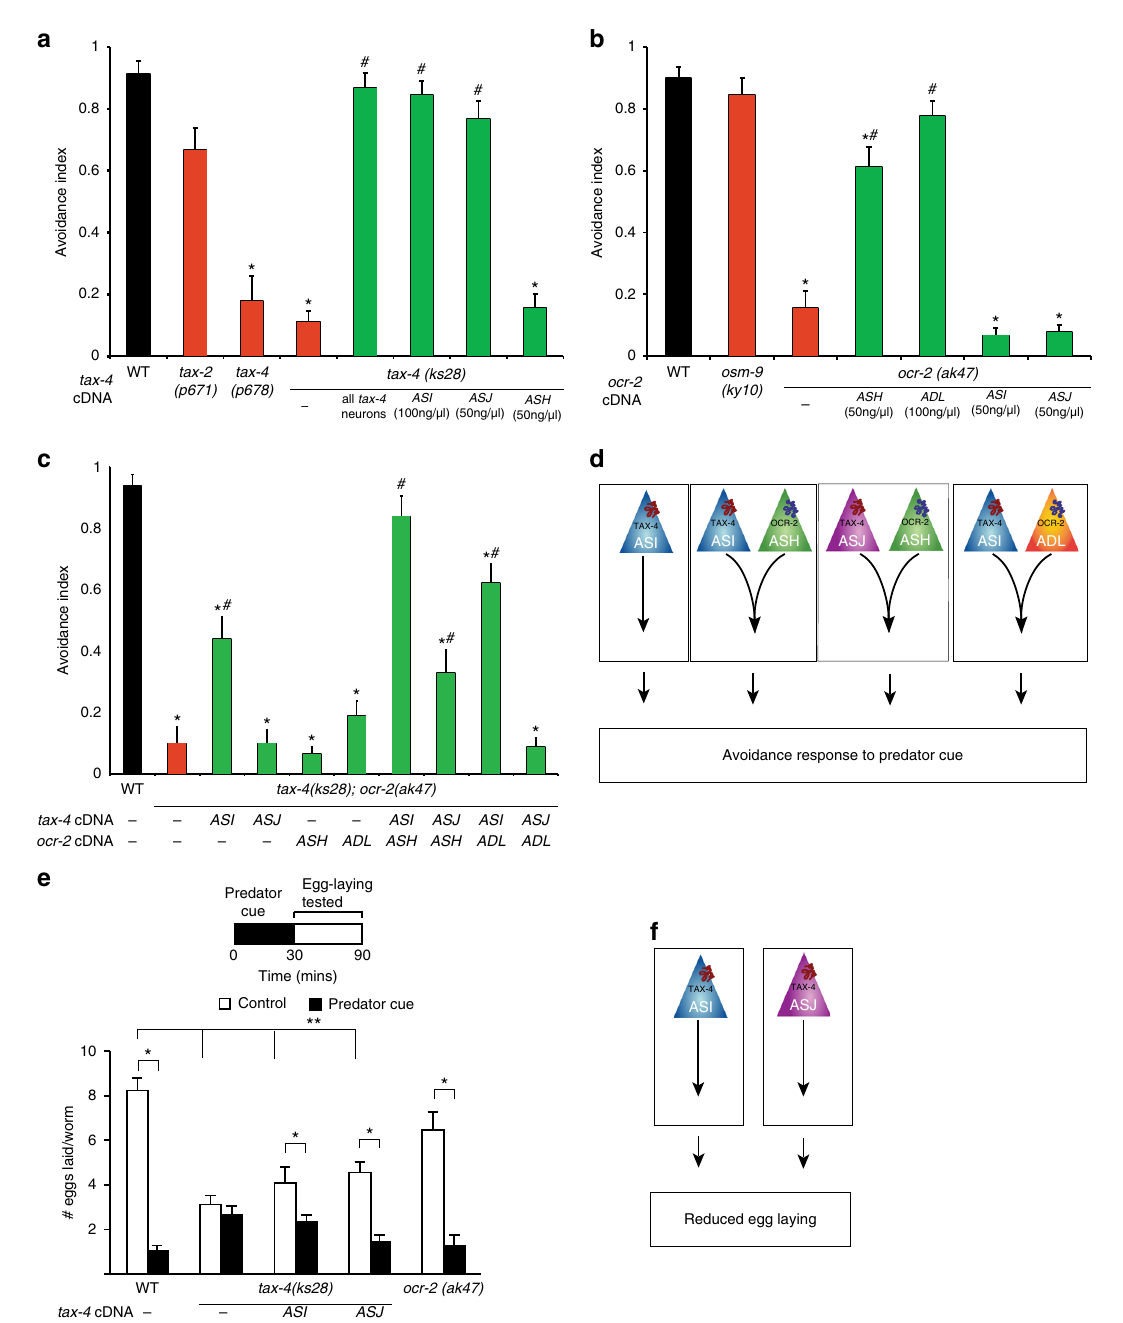
Fig. 3 A redundant C. elegans signaling network enables responses to predator cue. a Mutants lacking the alpha subunit of the CNG channel ( tax-4) , but not the beta subunit ( tax-2) , are defective in their response to predator cue. Restoring wild-type tax-4 cDNA using an ASI- or ASJ-speci fi c promoter is suf fi cient to restore normal behavior to tax-4 mutants. b Mutants lacking the TRPV channel subunit ocr-2 , but not osm-9 , are defective in their response to predator cue. OCR-2 is speci fi cally required in ASH sensory neurons. c A tax-4;ocr-2 double-mutant is also defective in avoiding predator cue and wild-type behavior is restored when TAX-4 is restored to ASI and OCR-2 is restored to ASH neurons. Restoring TAX-4 to ASJ and OCR-2 to ASH or ADL or restoring TAX-4 to ASI and OCR-2 to ADL is able to partially restore wild-type behavior to the double mutants. Moreover, expressing tax-4 in ASI but not ASJ is suf fi cient to rescue the double-mutant phenotype. d Schematic showing four redundant pathways (ASI acting independently, ASI and ASH, or ASI and ADL, or ASJ and ASH acting together) driving avoidance to P. paci fi cus predator cue. e C. elegans egg-laying reduction requires functional TAX-4 signaling in ASI and ASJ neurons. OCR-2 is not required for this behavior. f Schematic showing that TAX-4 acts in ASI and/or ASJ neurons to reduce egg laying upon longer-term exposure to predator cue. Averages and s.e.m. are shown. a – c n = 30 animals and in e, n > 35 tested for each condition, * p < 0.05 compared with controls, # p < 0.05 compared to mutants, ** p < 0.05 comparing eggs laid by mutants and wild-type animals obtained using Fisher ’ s exact t -test with